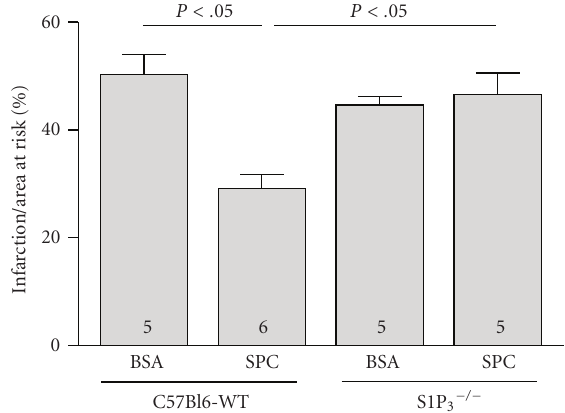
Figure 4: The S1P 3 lysophospholipid receptor is required for car- dioprotection by SPC. Infarct size/area at risk was determined in S1P 3 -deficient mice and their matching wild-type controls (C57BL/6) after treatment with SPC (1.25 μ g/g body